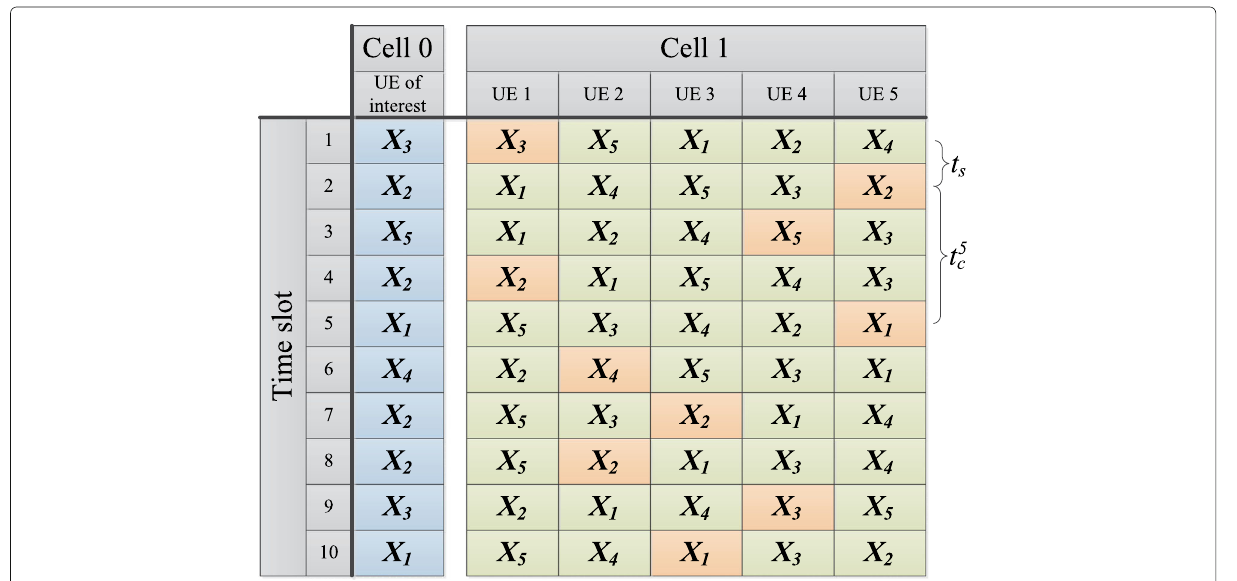
Fig. 4 An example of a random pilot schedule for the UE of interest and potential contaminators in a neighboring cell. Green boxes represent pilots, which are orthogonal to the pilot from the UE of interest. Red boxes represent contamination and x i denotes a pilot